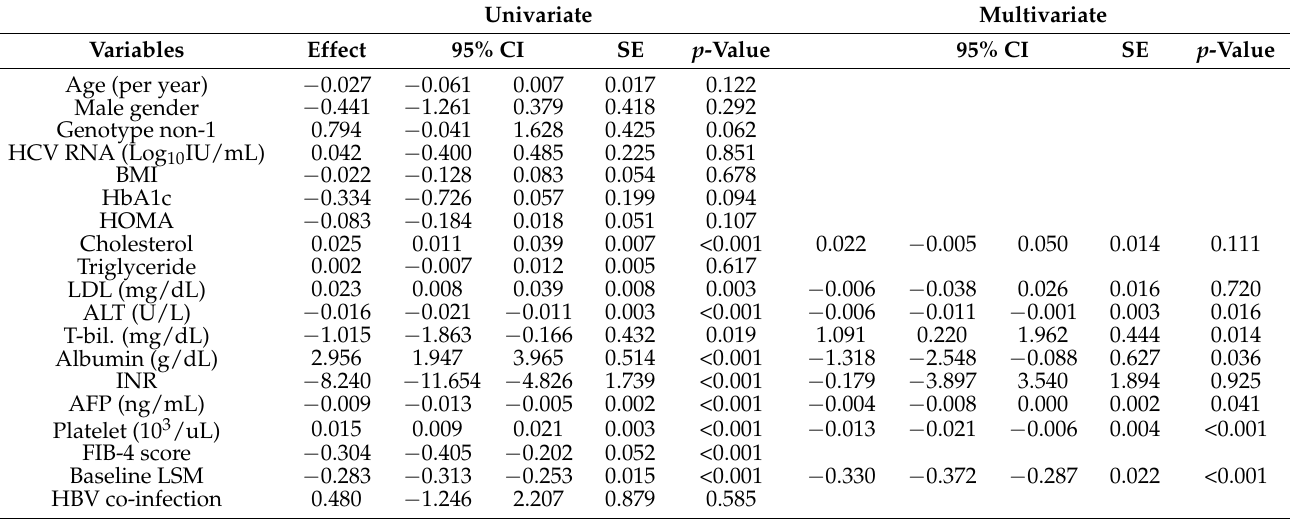
Table 2. Linear regression analysis of factors associated with LSM